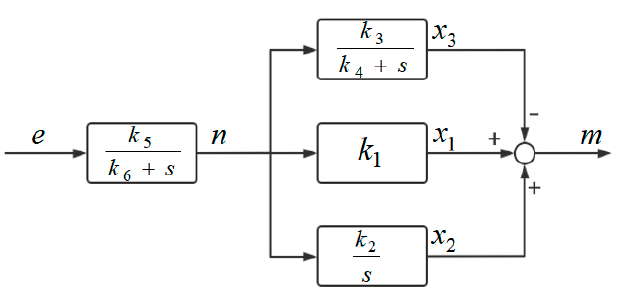
Figure 4. PID controller C 2 ( s )